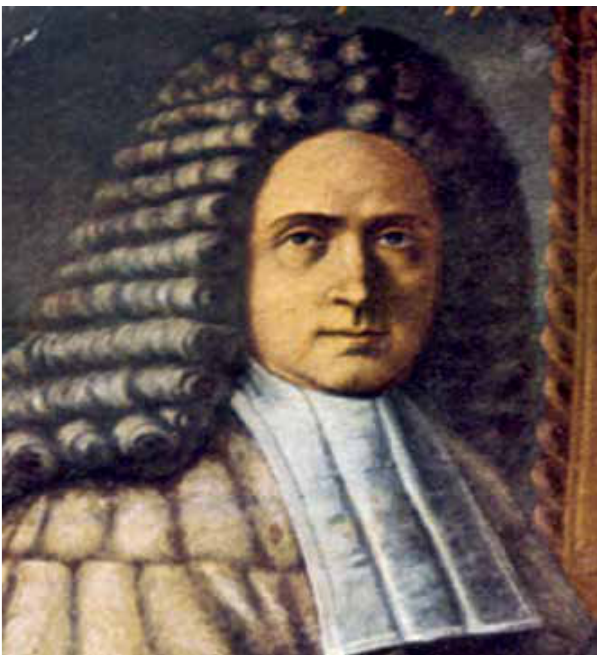
Figure 1: Giovanni Battista Morgagni, who provided one of the earliest recorded descriptions of emphysema in